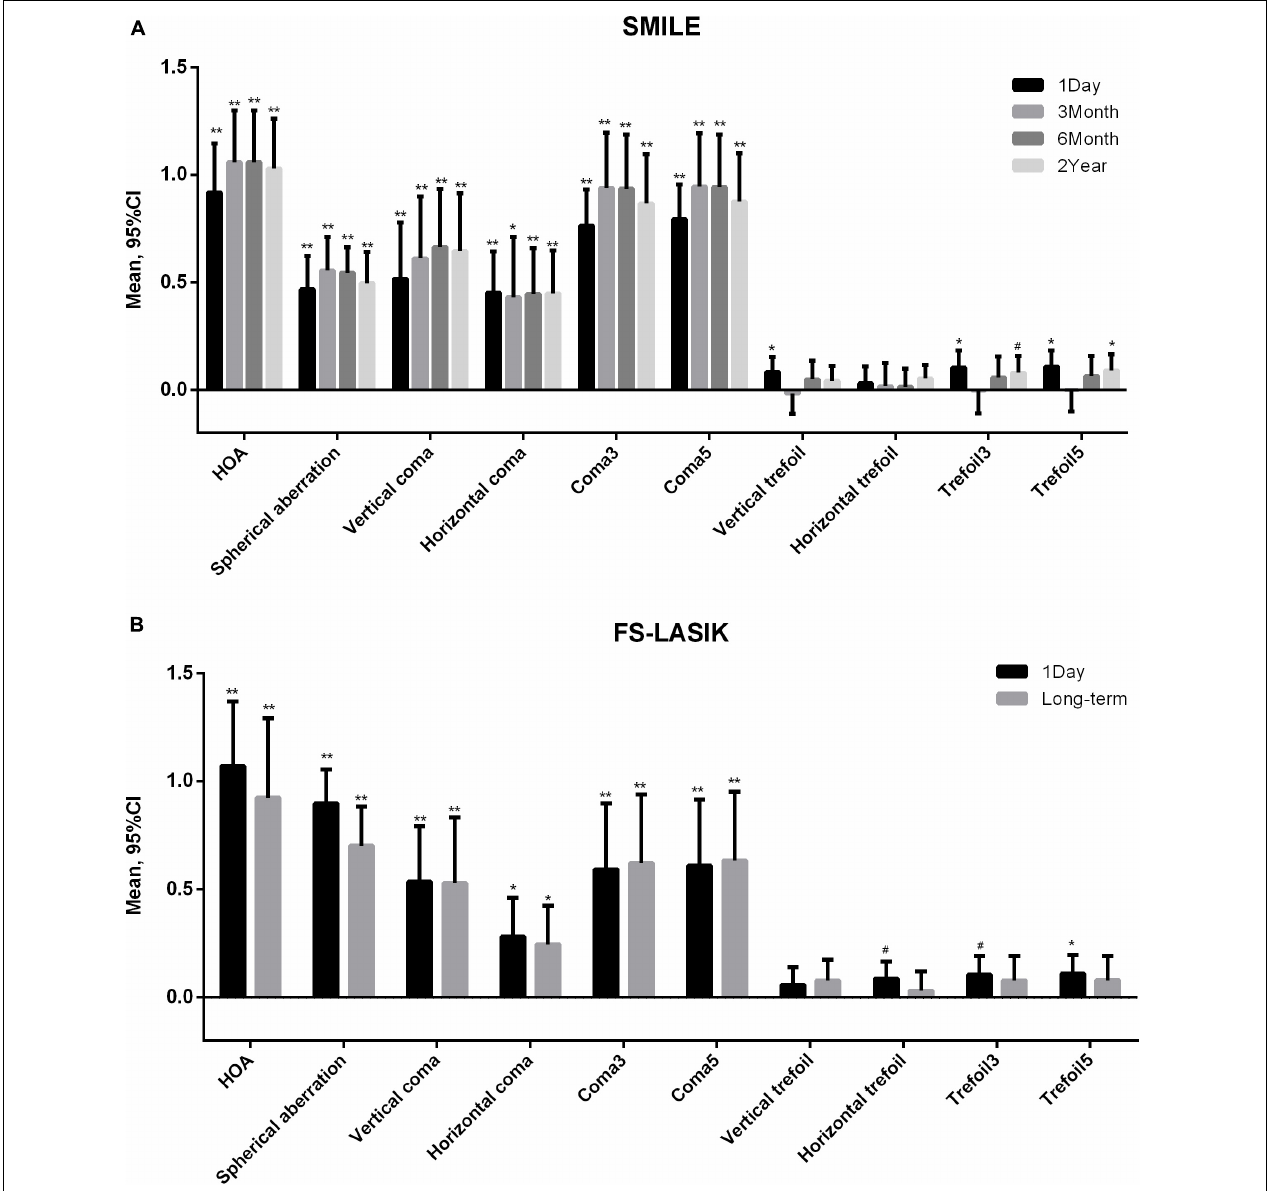
FIGURE 1 | Variations of higher-order aberrations after (A) small incision lenticule extraction (SMILE) and (B) femtosecond laser-assisted in situ keratomileusis (FS-LASIK). Compared with baseline ** p < 0.001, * p < 0.01, # p < 0.05. HOA, total higher-order aberration; Coma3, 3rd order coma; Coma5, 3rd and 5th order coma; Trefoil3, 3rd order trefoil; Trefoil5, 3rd and 5th order